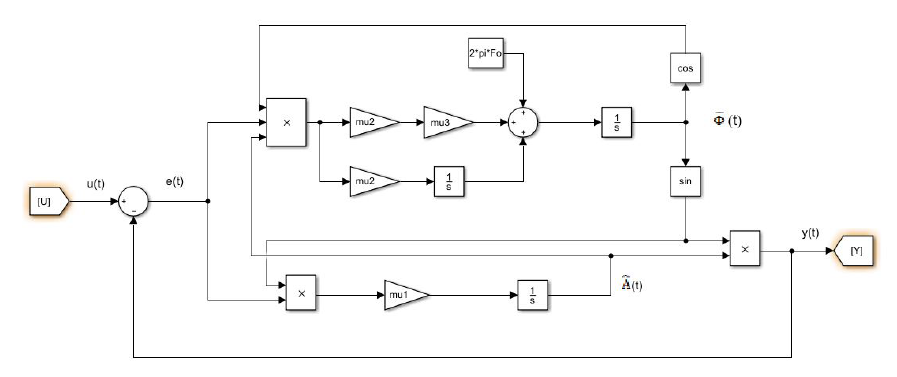
Figure 1. Bloc diagram of the algorithm.